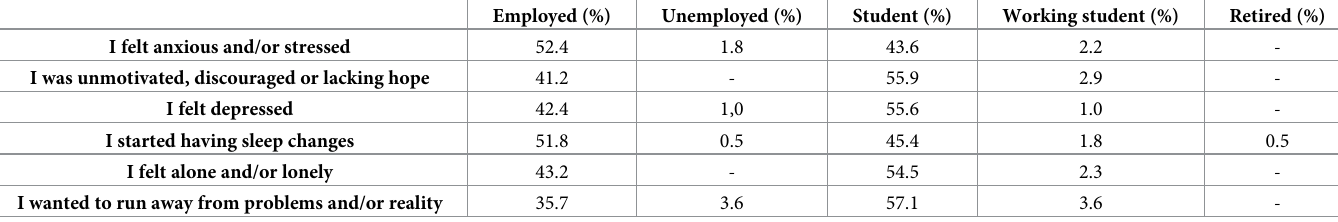
Table 6. Reasons that led to the consumption of illegal substances according to employment